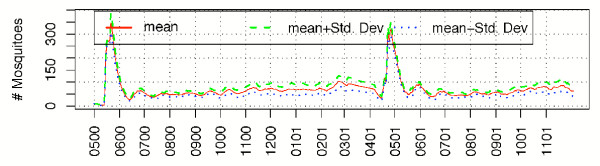
Simulated An. gambiae adult abundance at actual temperatures for 20 simulations